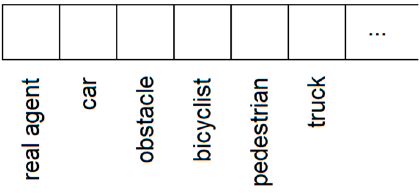
Figure 3. The identification of an agent. Each of the six attributes of the input instance has a binary value designating the presence or absence of a feature. The first attribute is 1 if the block identifies a real agent and 0 if it identifies a dummy agent. The following five attributes constitute a one-hot encoding of the agent type, e.g., the second attribute is 1 if the agent is a car and 0 if it not a car, and so on.